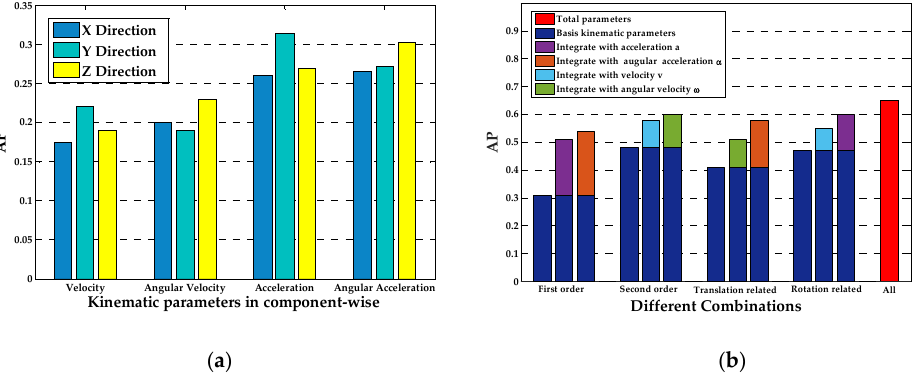
Figure 14. Significance of the kinematic parameters. ( a ) AP for componentwise parameter. ( b ) AP for different combinations.